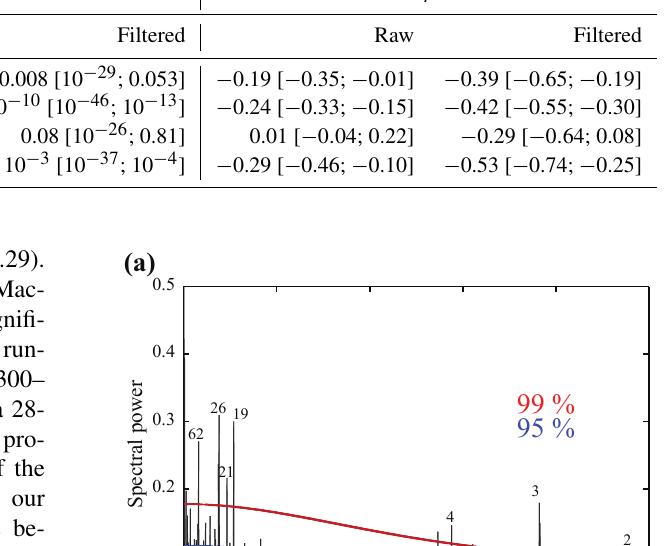
(Fig. 4a: annual correlation: r = − 0 . 27, p < 10 − 10 ; 5-year running mean: r = − 0 . 43 (and − 0.69 with a 25-year low- pass filter; Fig. S5)).